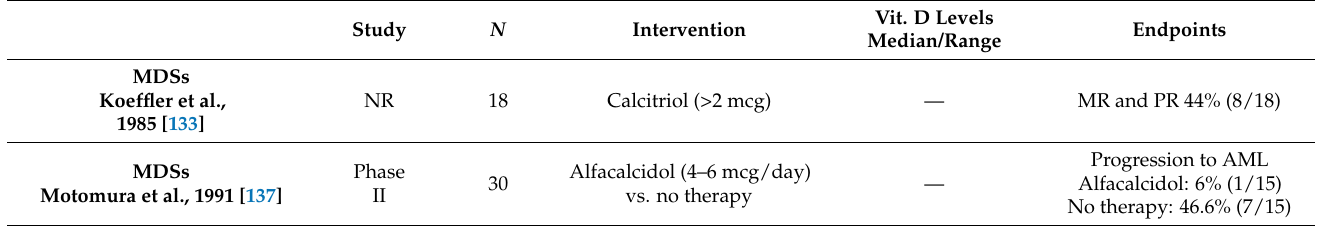
Table 1. Interventional studies evaluating the efficacy of vitamin D’s administration in treating hematologic malignancies.